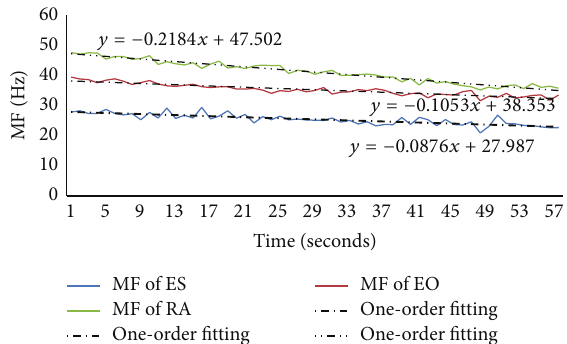
Figure 4: Prone bridge.